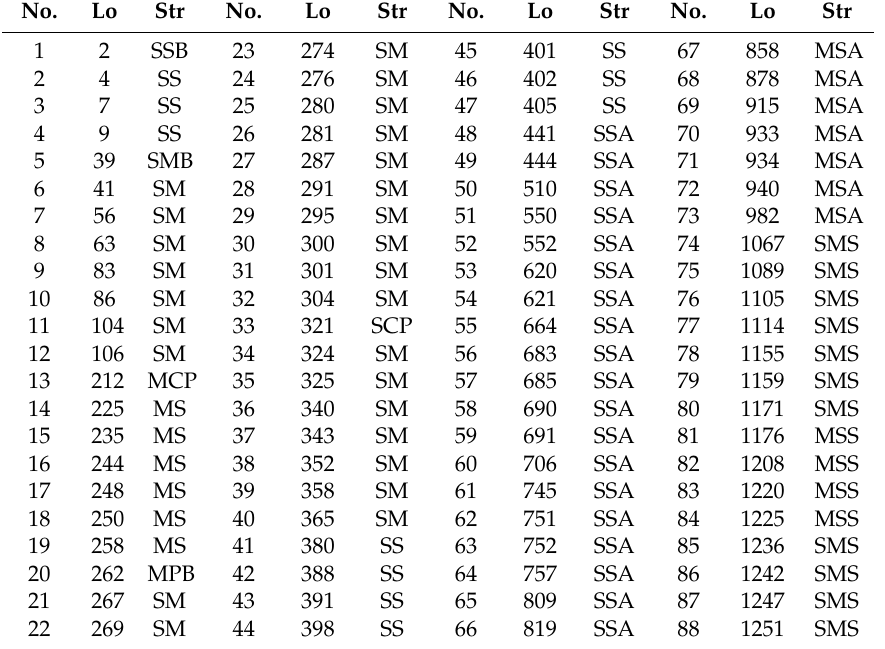
Table 8. Sensor placement results (“Lo” represents node location of the sensor placement and “Str” represents the corresponding structure description).